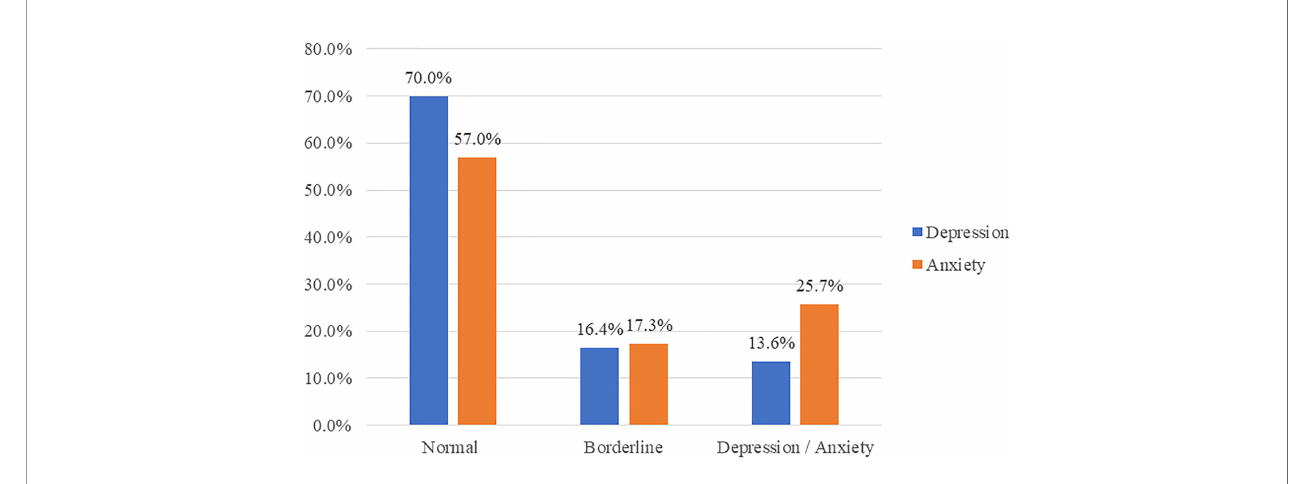
FIGURE 1 | Prevalence of anxiety and depression using HADS.